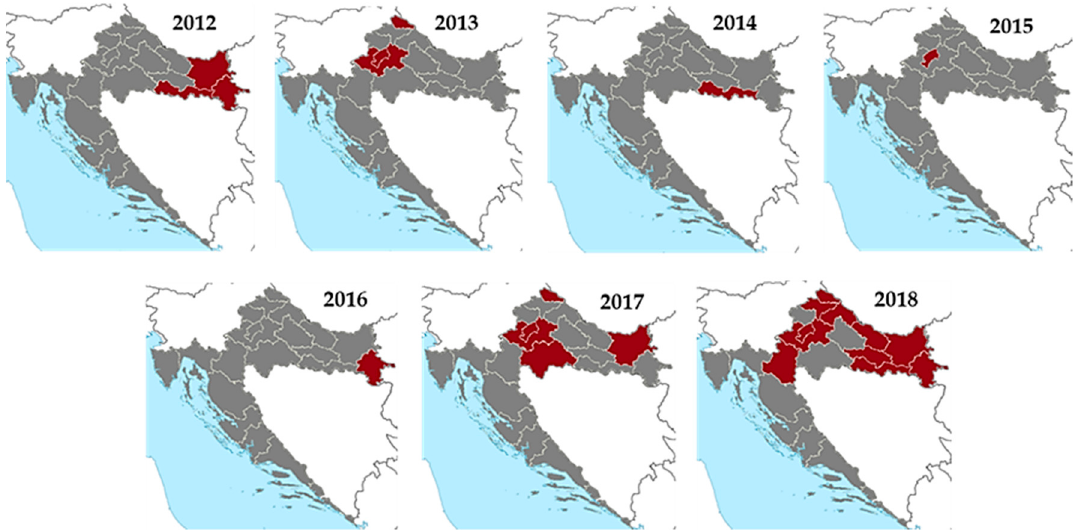
Figure 2. Geographic distribution of human WNV infections, 2012–2018.